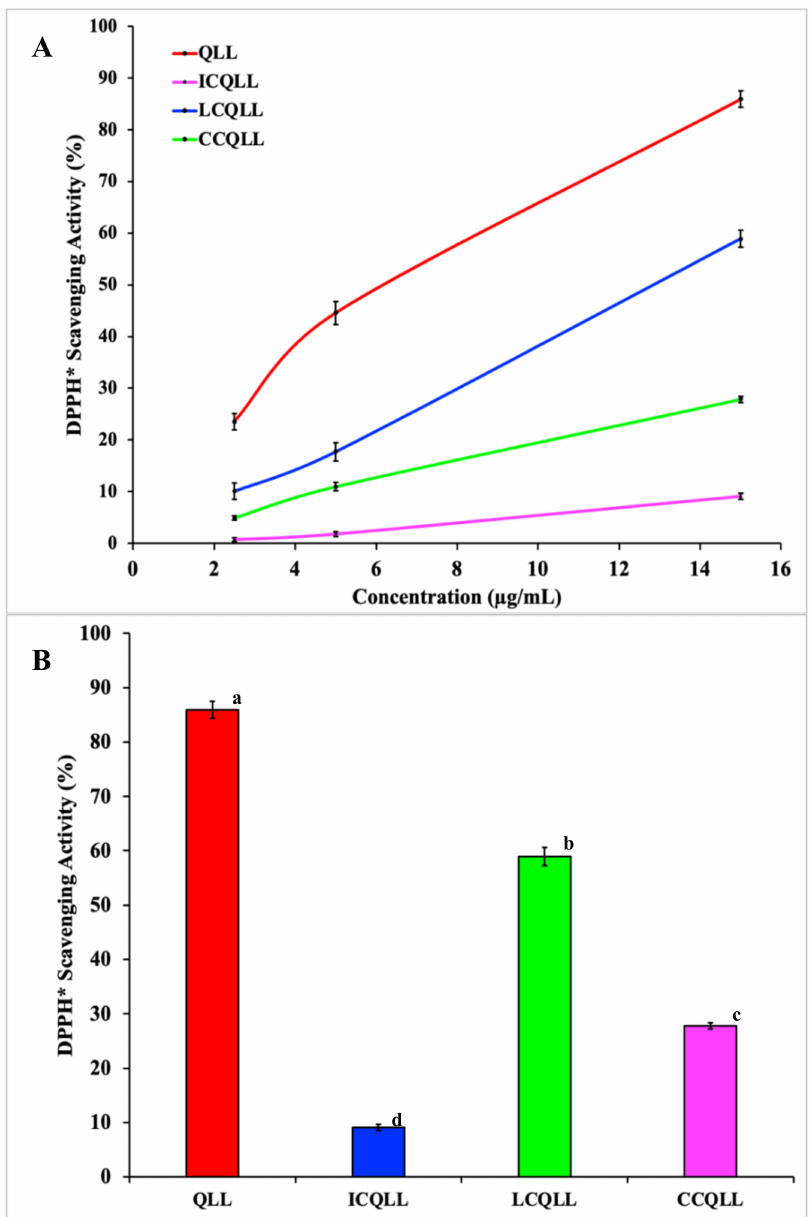
Figure 4. E ff ect of the coating material on the antioxidant activity of polysaccharide coated quercetin loaded liposomes. ( A ) Scavenging activity as a function of liposomes concentration. ( B ) Comparative scavenging activity at liposomes concentration of 15 µ g / mL (a, b, c and d indicate the Tukey´s HSD test